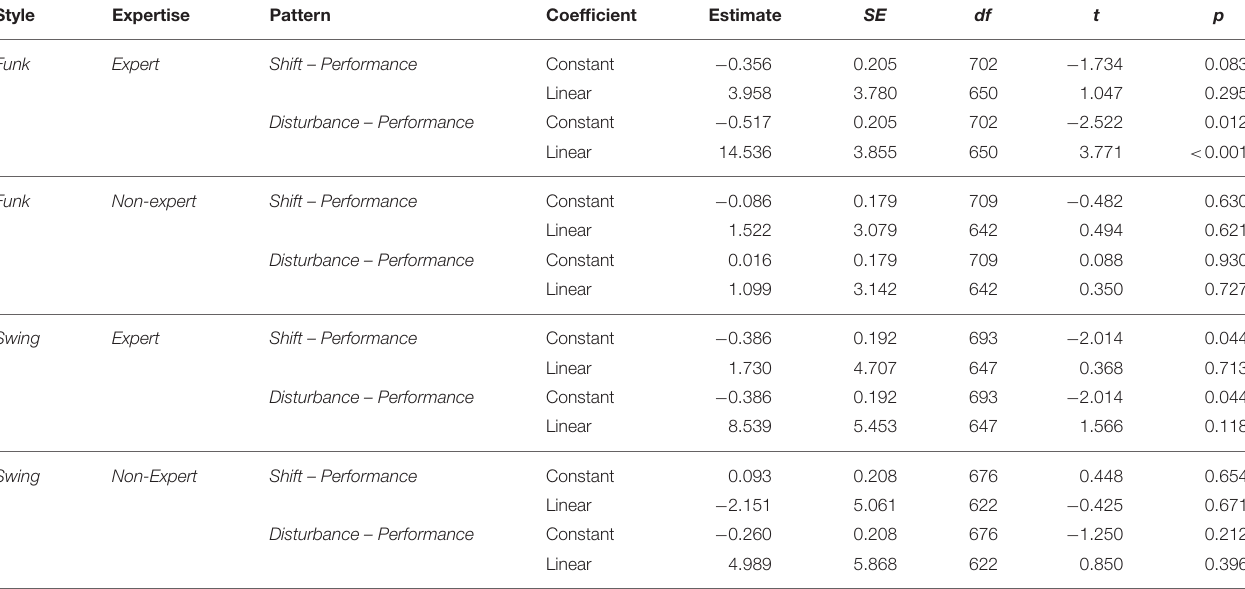
TABLE 6 | Regression models for the relationship between Density-adjusted STD and Irritation